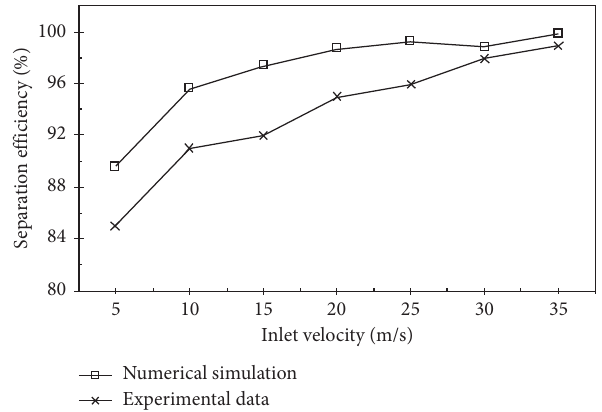
Figure 9: Particle separation efficiency as a function of inlet ve- locity compared with calculated results and previous